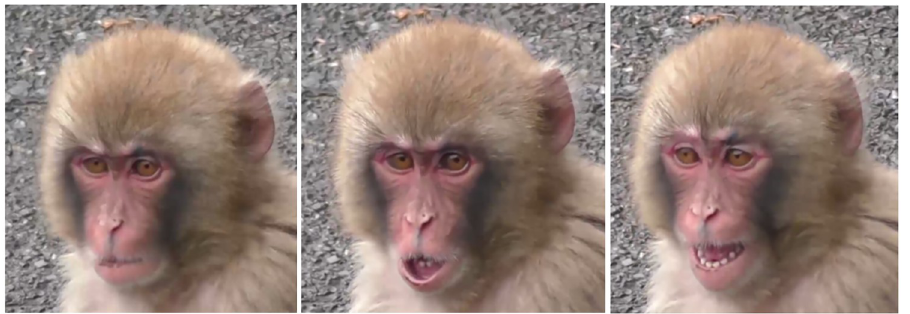
Fig 17. Left: Neutral; Centre and Right: varied AUs during